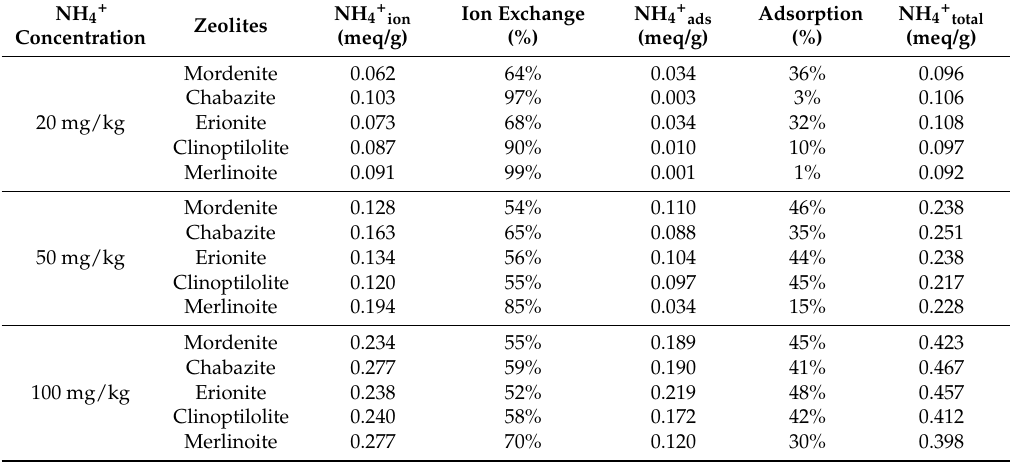
Table 2. Results of zeolite removal of NH 4+ and the proportions of ion exchange and adsorption in different initial NH 4+